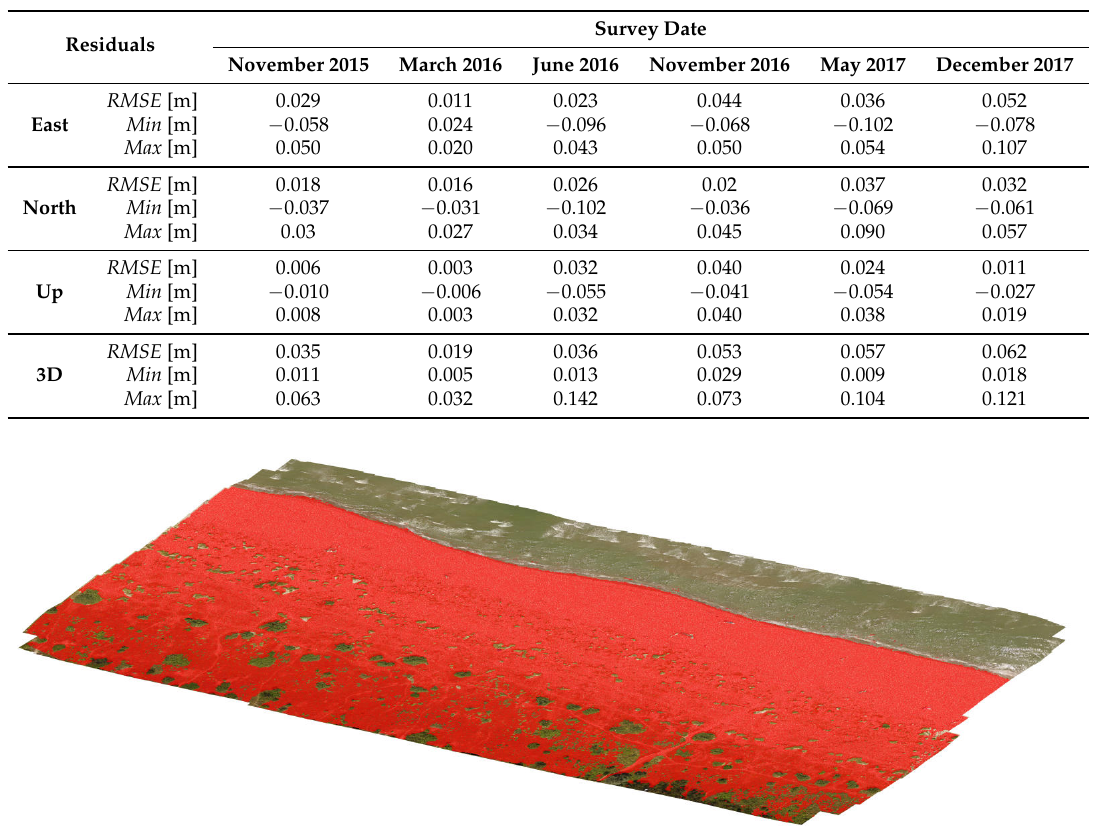
Figure 7. Dense point cloud after the detection of the ground points by the use of the slope-based classification algorithm in Agisoft Photoscan